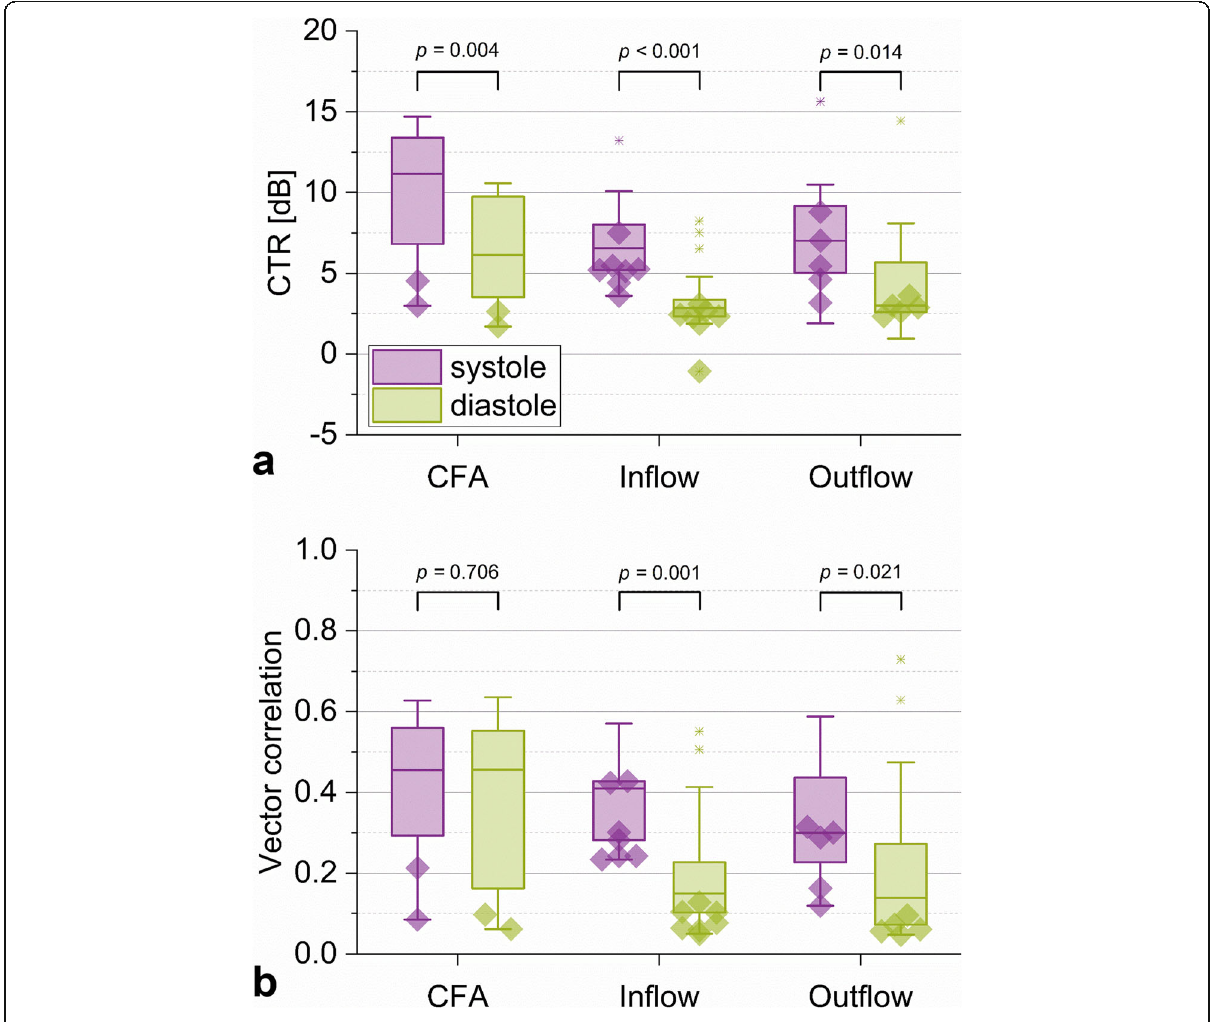
Fig. 5 Comparison of contrast-to-tissue ratio (CTR) ( a ) and vector correlation ( b ) between systole (purple) and diastole (green) per location. Edges of the boxes indicate the 25th (Q1) and 75th (Q3) percentiles, whereas whiskers give the minimum and maximum values. Outliers are presented as crosses. The values corresponding to measurements assigned as “ loss of contrast ” by the observers are indicated with a diamond shape.* p < 0.05, ns Not significant, CFA Common femoral